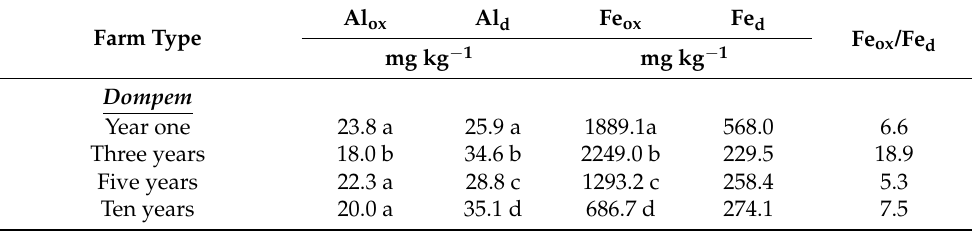
Table 3. Pedogenic Al and Fe contents and the active Fe ratio in soils of different farm types from Dompem ( n = 9) and Adansam ( n = 11) with coefficients of variation and p -values. Farm